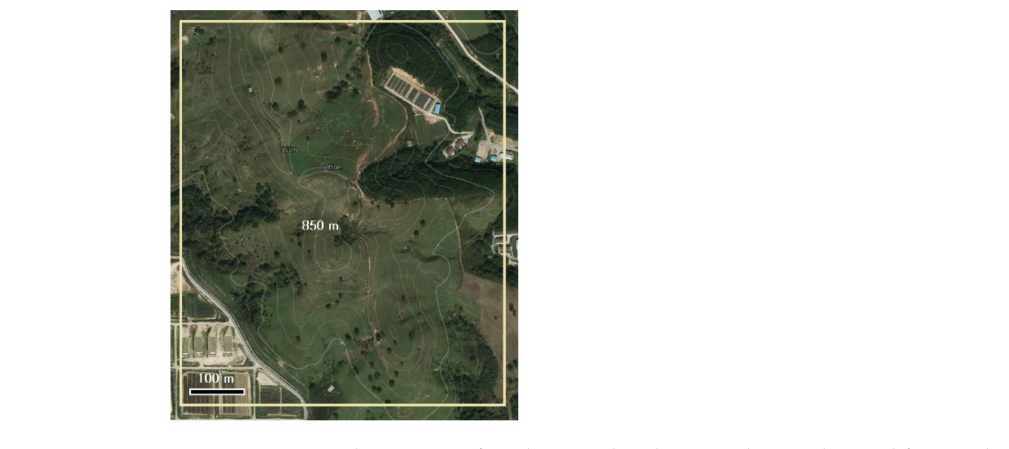
Figure 1. Topographic survey of study site. The photograph was obtained from Kakao Map (www. map.kakao.com, assessed on 21 April 2021). Table 1. Plant and topographic characteristics for the five plant